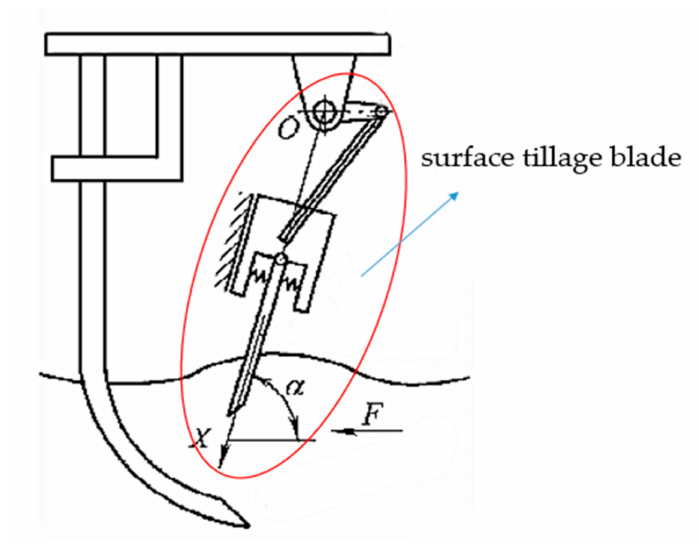
Figure 5. Surface tillage blade structure